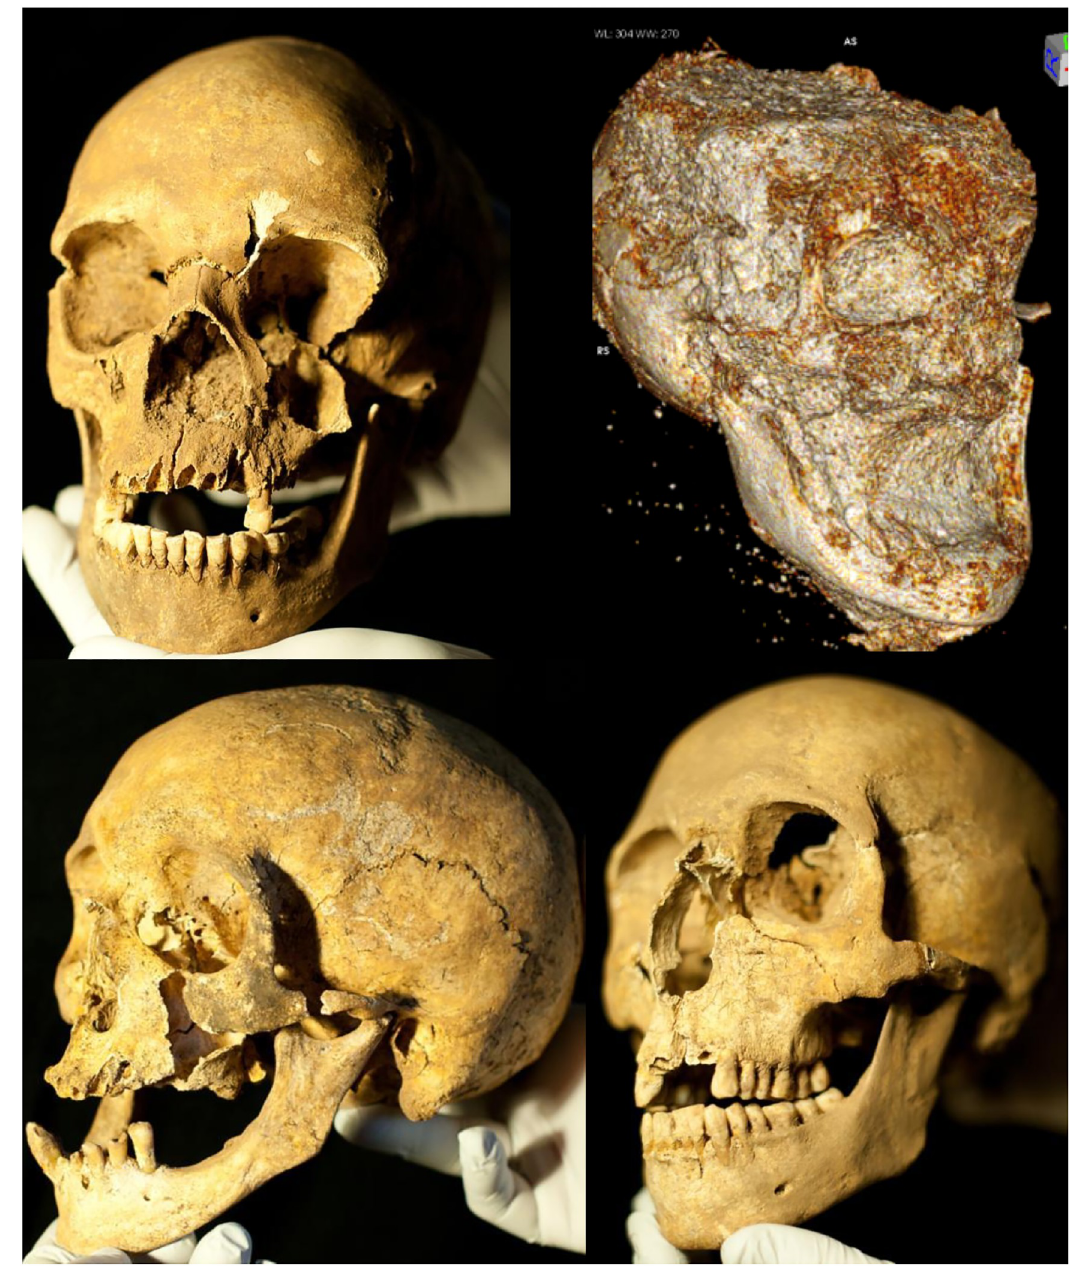
Fig 7. YNH4 Skull preservation. Clockwise from top left: YNH4 Individual A; B (CT scan due to condition); B2 and B3. Photos by Stephanie Anestis; radiograph by GJC, TG and NAP.